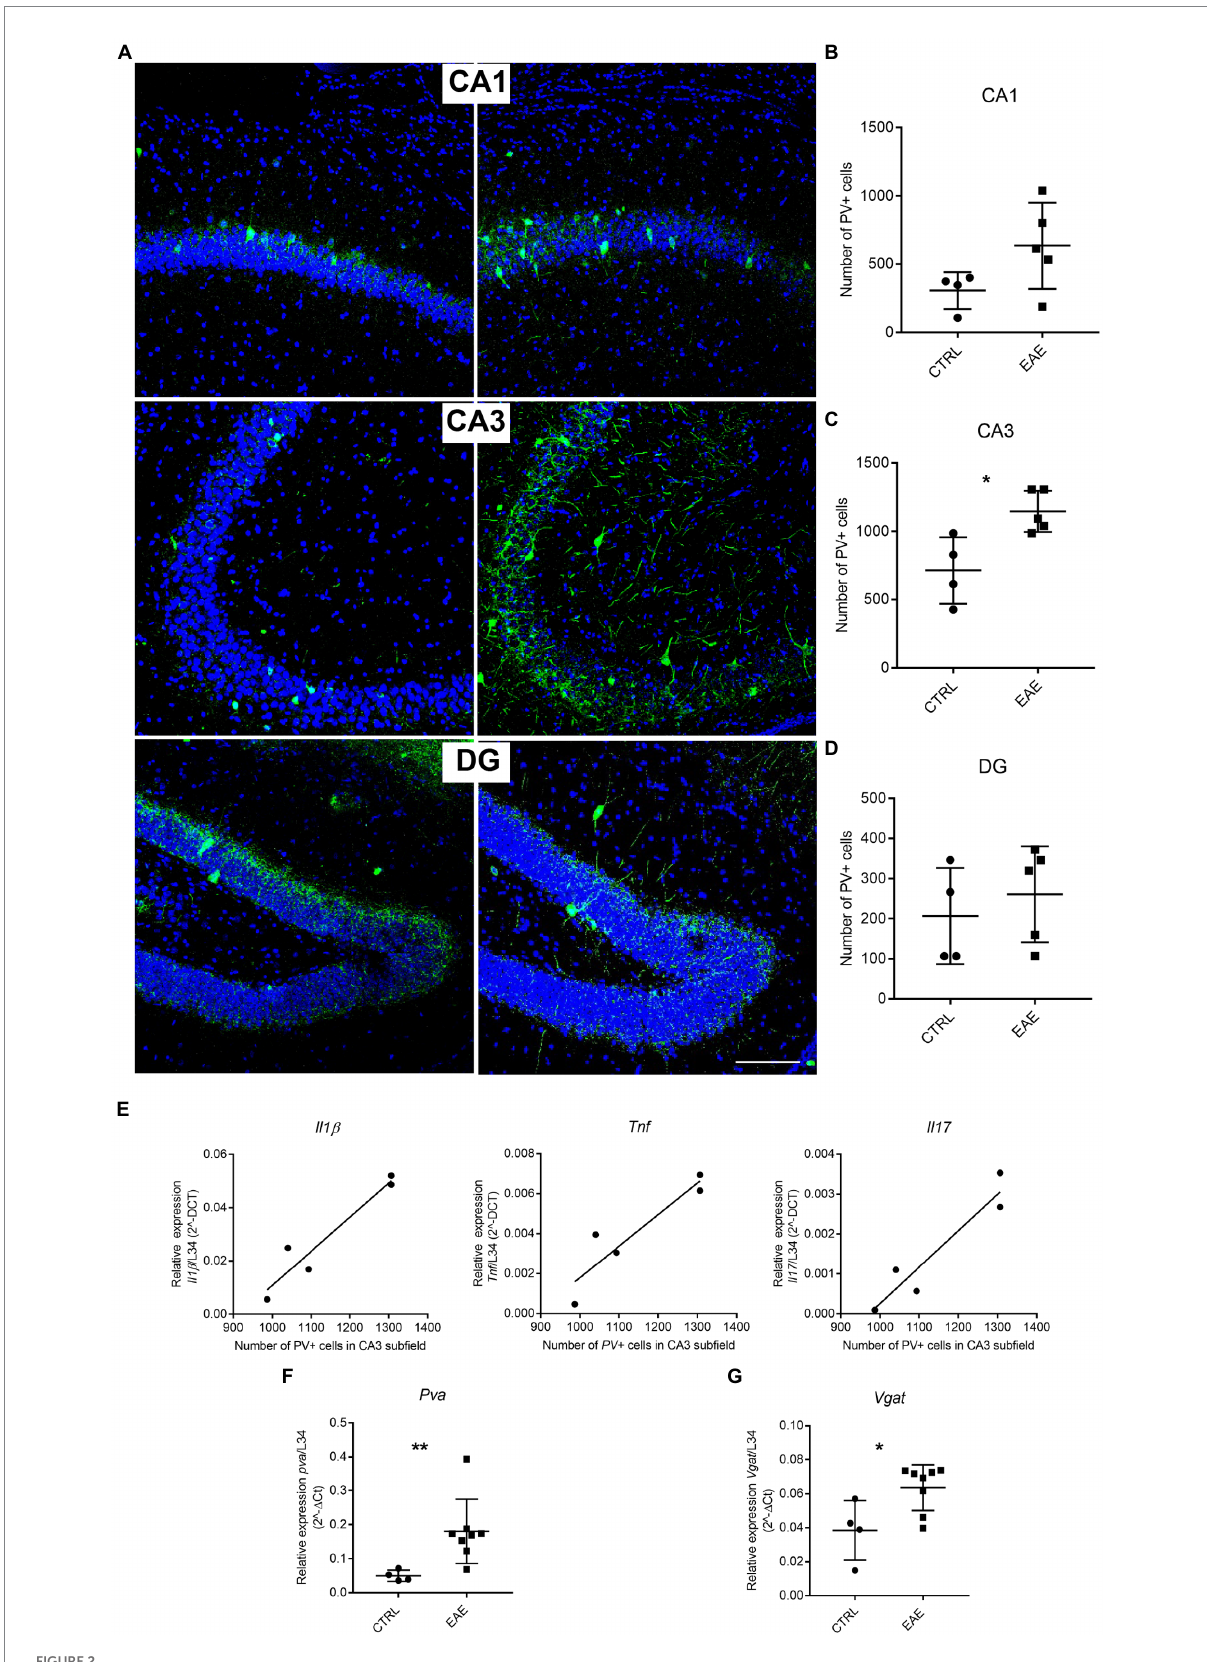
FIGURE 2 Experimental autoimmune encephalomyelitis (EAE) induces changes in Parvalbumin (PV) expression. (A) Representative micrographs of PV- immunostained (green) hippocampal sections counterstained with Neurotrace (blue) from CTRL and EAE mice. Increased PV-immunoreactivity